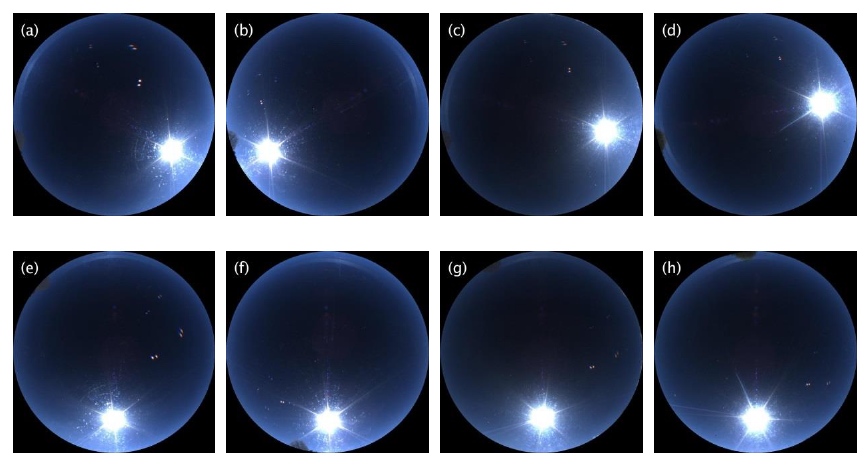
Figure 3. Several TCI images of different imaging times and the results after rotation. Panels (a) and (b) are the TCI images shot in the morning and afternoon of 8 October 2012, image (c) is captured on 5 April 2013, (d) is obtained on 11 June 2013, with (e) through (h) as the corresponding rotation images of (a) to (d)